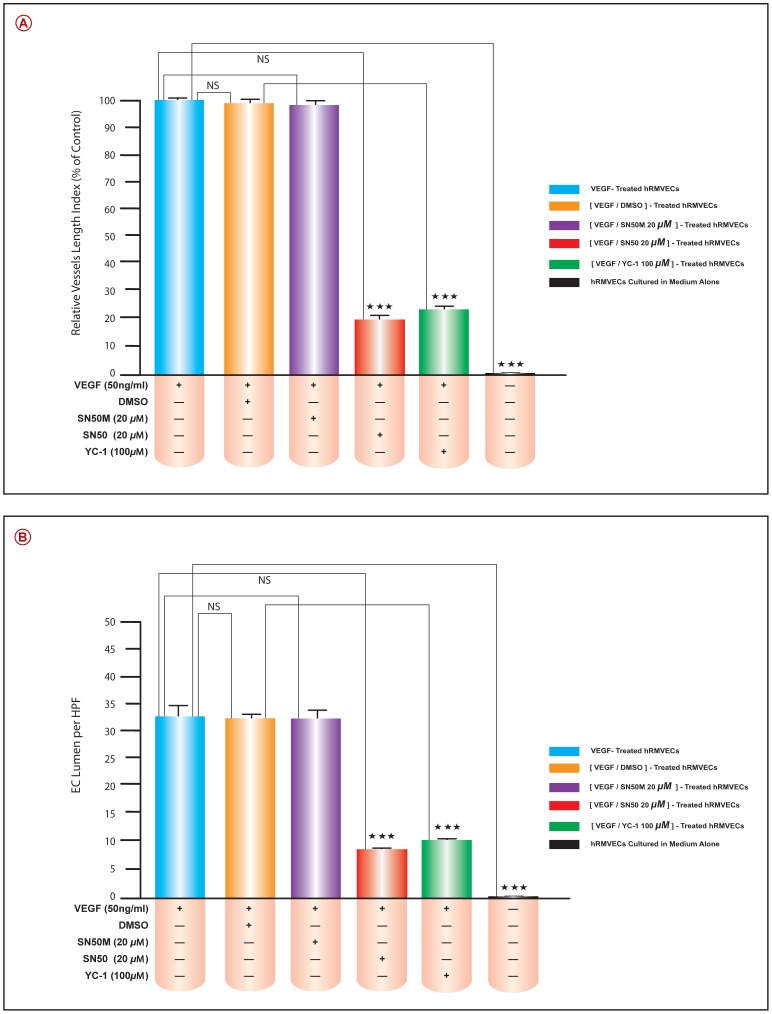
Assessments of the Inhibitory Effects of YC-1 on hRMVECs.A. Quantitative Assessments of the Inhibitory Effects of YC-1 on Tube Formation. The capillary tubules were significantly shortened when treated with YC-1 or SN50, as compared to their respective controls; DMSO or SN50M, respectively. Data represent means ± SEM from three independent experiments with 3 replications in each experiment [*P<0.05; **P<0.01; ***P<0.001, as compared with the DMSO-treated controls by Student’s two-tailed t-test]. B. Quantitative Assessments of the Inhibitory Effects of YC-1 on Lumen Formation. The EC lumenal area were quantitatively measured over 24 hours by tracing EC lumenal areas using the Metamorph software program in order to systemically analyze EC lumen formation. The effects of addition of VEGF, DMSO, SN50M, SN50, and YC-1 on EC lumen formation over the time course of 24 hours, with the bar graph highlighting EC lumens per high power field [HPF] at 24 hour time point. SN50 and YC-1 treatments significantly [***P<0.001] decreased the number of lumen formed in hRMVECs as compared to their respective controls, SN50M and DMSO, respectively. Graph showing the mean number of EC lumens per high power field [HPF] ± S.D. [n = 3]. ***P<0.001; **P<0.01, as compared with controls.